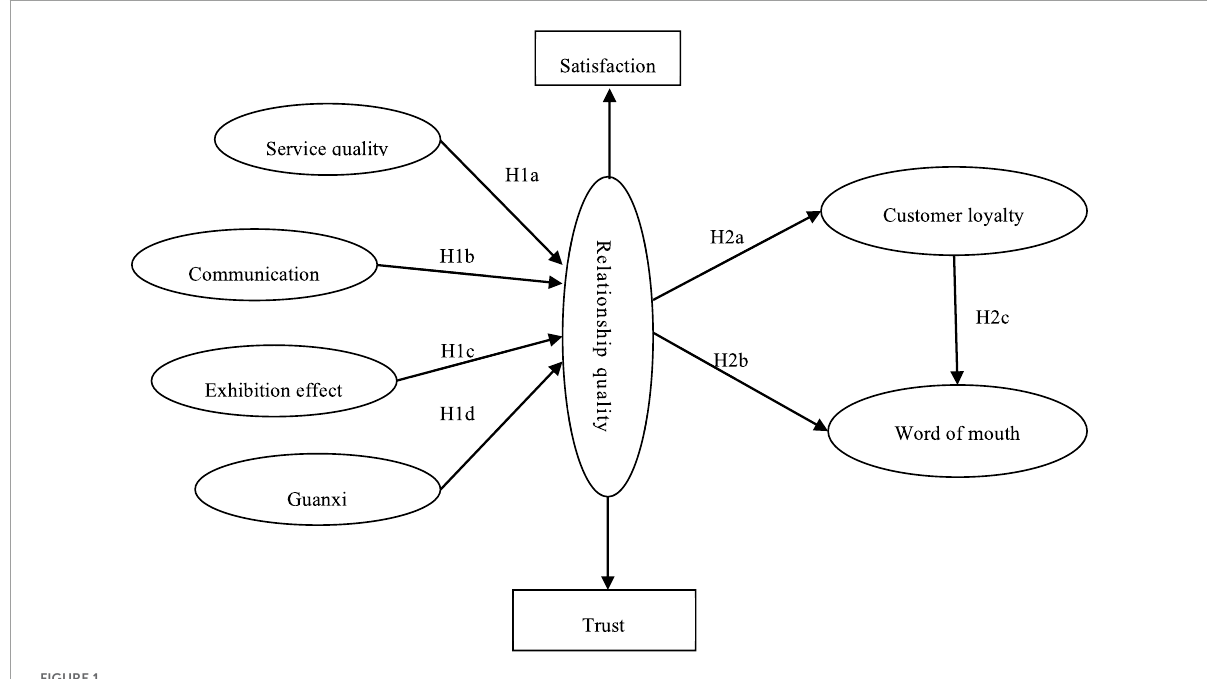
FIGURE1 Conceptual model of relationship quality between organizers and